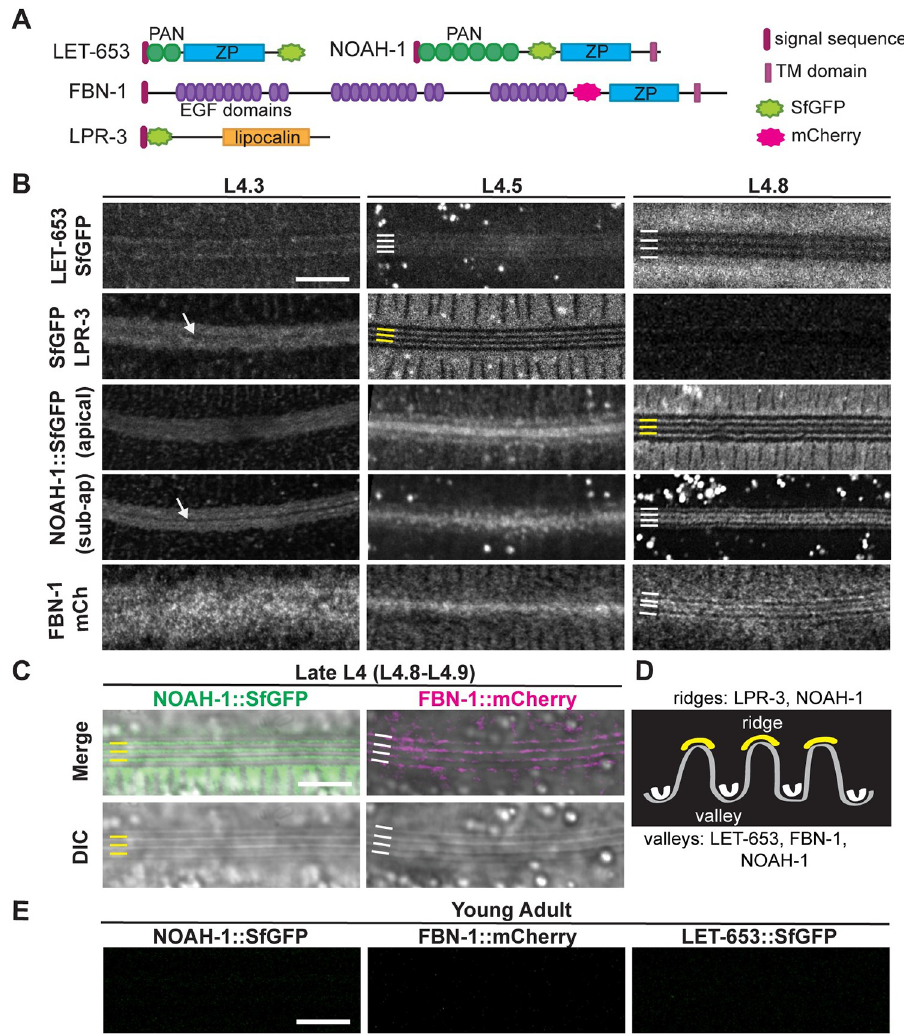
Fig 7. Provisional matrix patterns presage the ridges and valleys of adult-stage alae. (A) Diagrams of provisional matrix components. (B) Representative confocal slices show the dynamic distributions of indicated fusions in animals from mid- to late-L4. LET-653::SfGFP (strain UP3746, 20˚C). SfGFP::LPR-3 (strains UP3666 or UP3693, 20˚C). NOAH-1::SfGFP (strain ARF503 25˚C). FBN-1::mCHERRY (strain ARF379, 25˚C). For NOAH-1::SfGFP, both apical and sub-apical confocal slices from the same animal are shown; 1/8 and 3/8 late L4 animals showed only the "ridge" or only the "valley" pattern, respectively, and 4/8 showed both patterns simultaneously. (C) Airyscan-processed images of late L4s, showing that apical NOAH-1 aligns with alae ridges and sub-apical FBN-1 aligns with valleys, as seen by DIC. (D) Schematic shows interpretation of apical patterns as alae ridges and sub-apical patterns as valleys. Correspondingly, on all micrographs, yellow lines indicate developing alae ridges and white lines indicate flanking valleys. (E) Provisional matrix factors disappear in adults. Confocal slices from same strains shown in A, at 20˚C 24 hours after mid-L4 stage. All images are representative of at least n = 5 per marker per stage. Scale bars: 5 μ